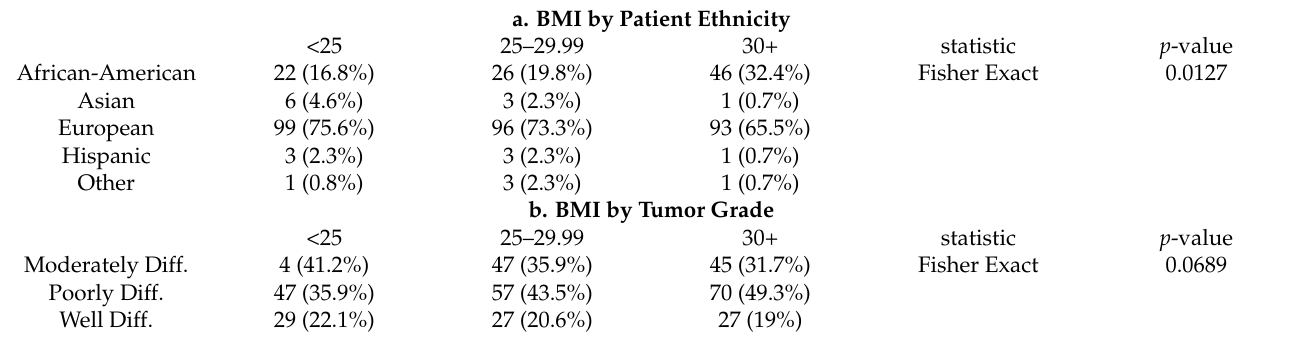
Table 2. Distribution of clinical characteristics in all